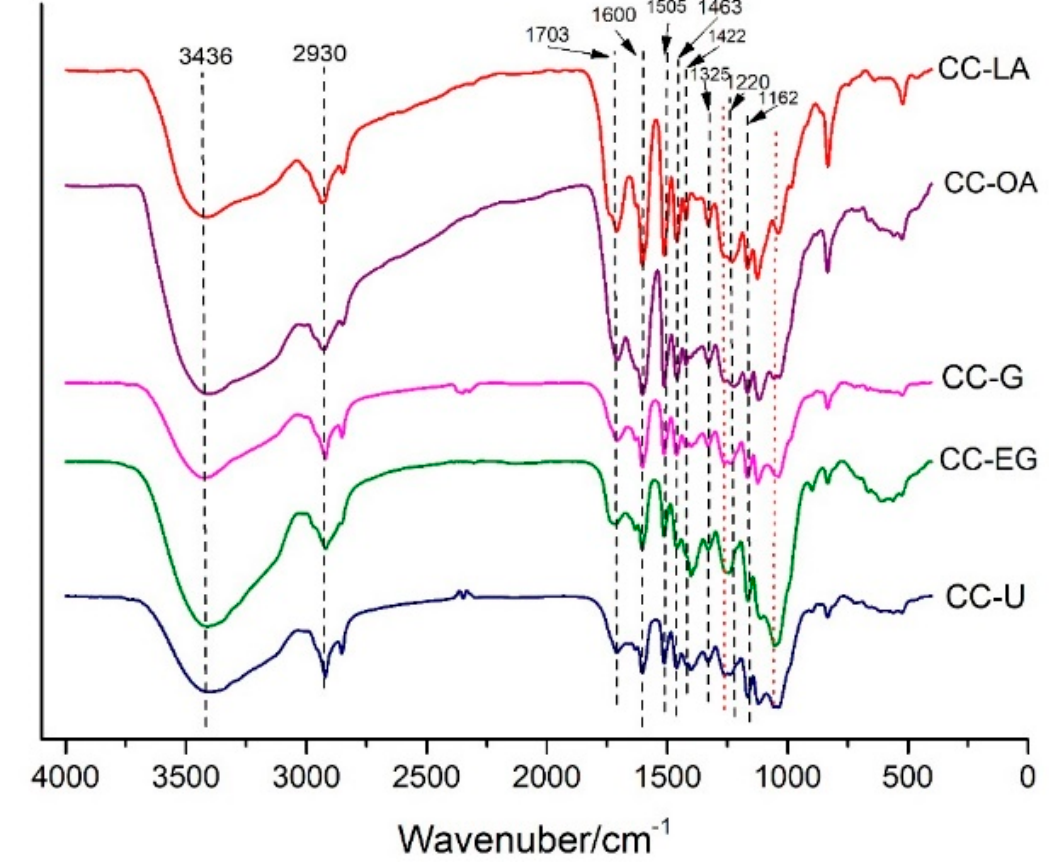
Figure 5. FTIR spectra of lignin treated with different DESs.